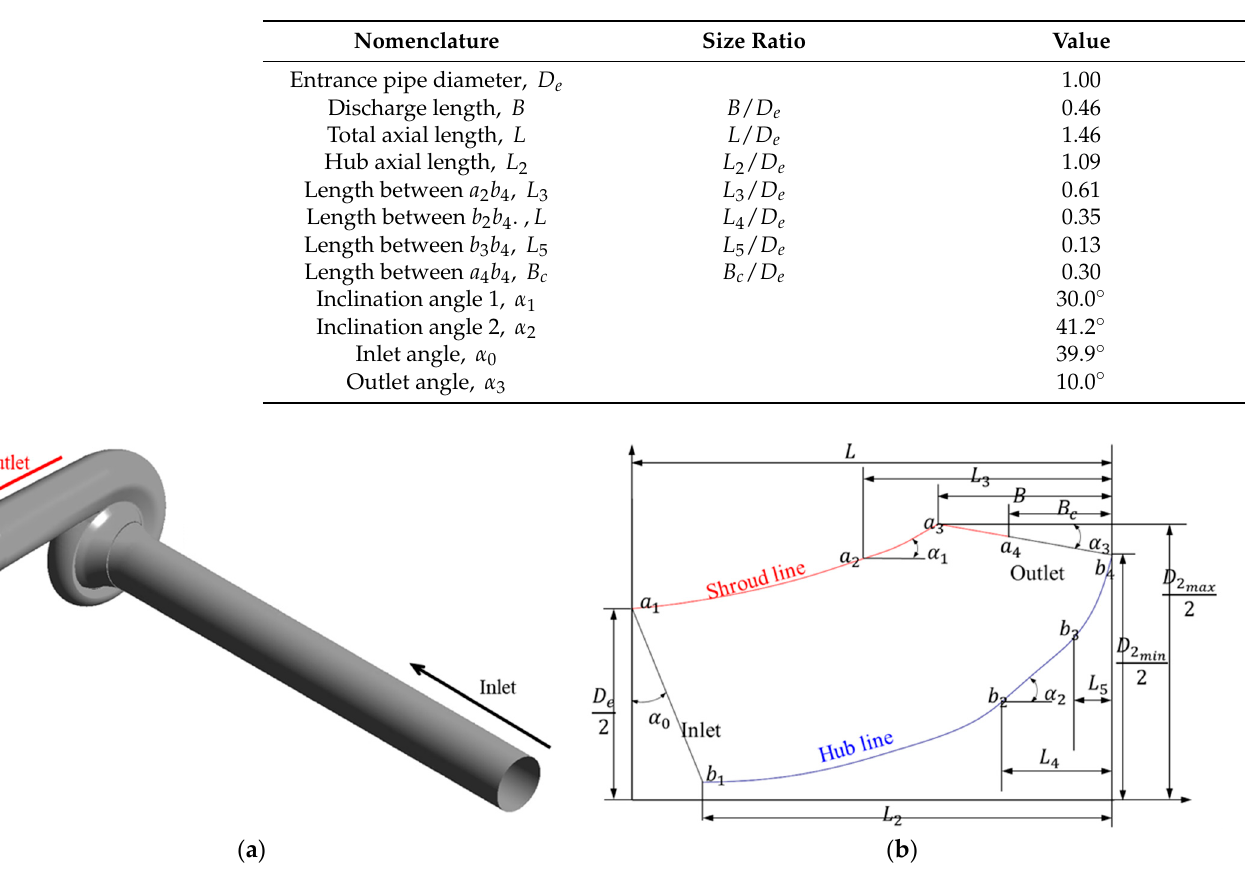
Figure 3. ( a ) Three-dimensional view and ( b ) meridional shape of screw centrifugal pump (SCP) model. Table 2. Specification of screw centrifugal pump model [30].